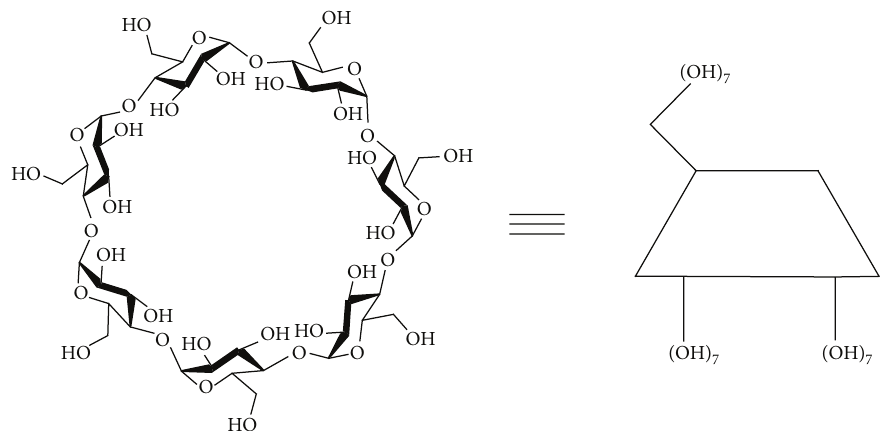
Figure 1: The schematic structure of 𝛽